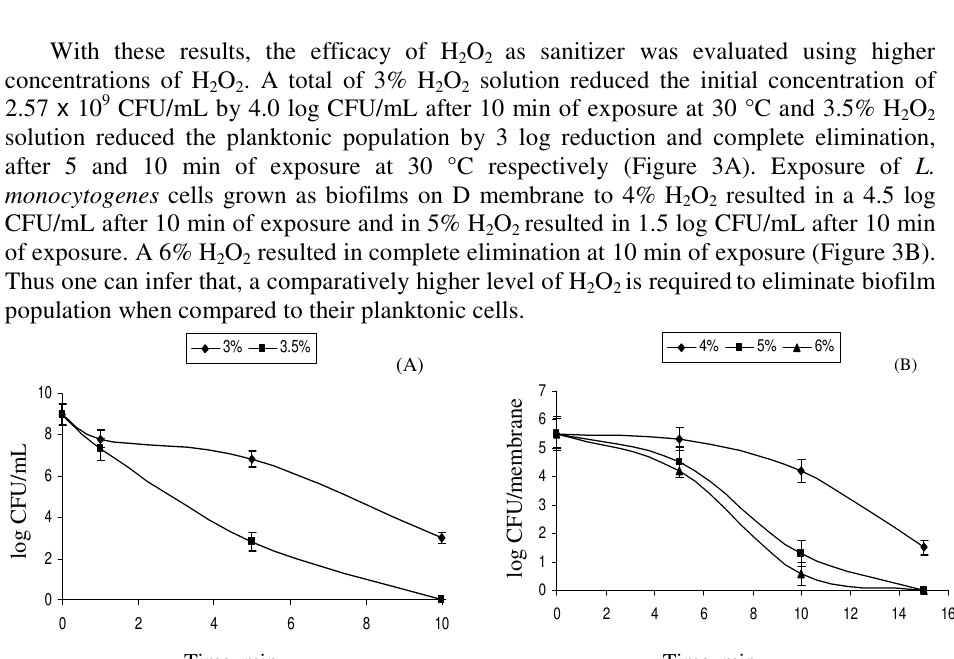
O on (A) planktonic cells and (B) biofilm 2 2